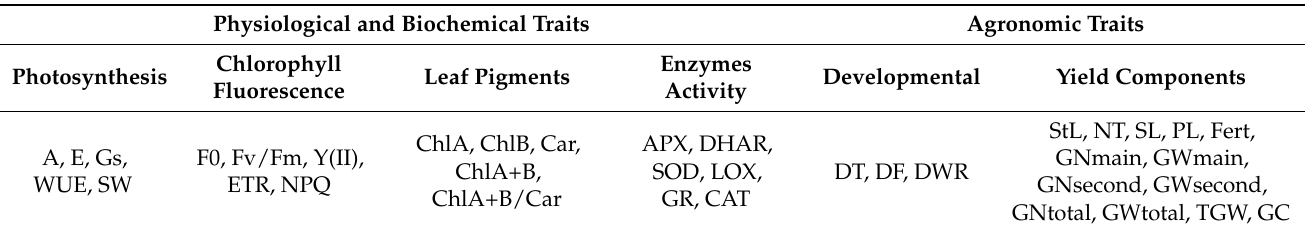
Table A2. Distribution of traits by physiological, biochemical and agronomical